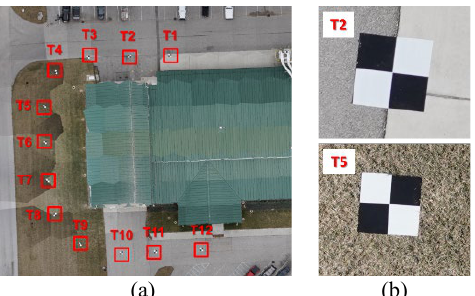
Figure 3. (a) Study site and deployed checkboard targets highlighted with the red boxes, and (b) sample images of the targets.